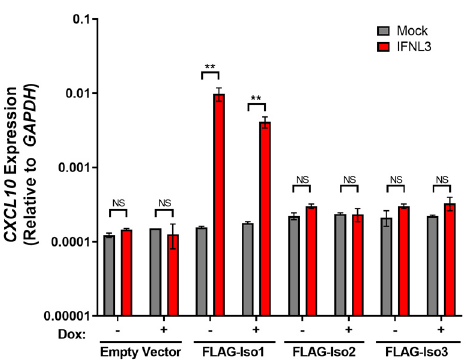
Figure 7. FLAG-Iso1 overexpression uniquely supports expression of the pro-inflammatory gene CXCL10 . HEK293T stable lines were induced ± dox (100 ng/mL) for 24 h, then mock or IFNL3 (100 ng/mL) treated for an additional 24 h, then evaluated by qRT-PCR for CXCL10 expression relative to GAPDH (representative data, two independent experiments). Error bars represent standard error of the mean. ** = p < 0.01, NS = not significant.